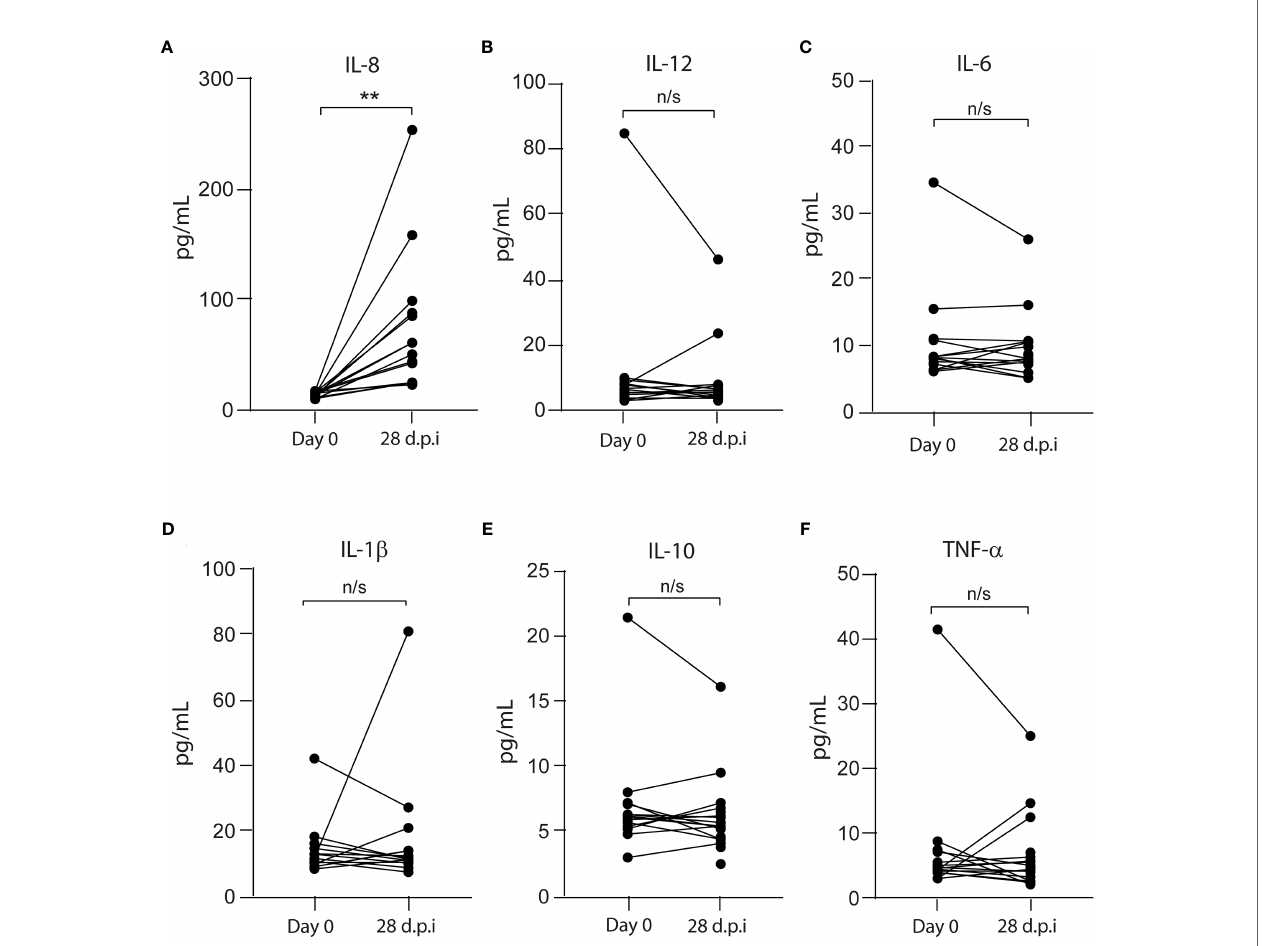
FIGURE 1 | Pro- and anti-in fl ammatory cytokines in the plasma from CoronaVac-vaccinated volunteers. The levels of (A) IL-8, (B) IL-12, (C) IL-6, (D) IL-1 b , (E) IL- 10, and (F) TNF- a were measured by fl ow cytometry as described in Materials and Methods . Data represented the cytokine level on each volunteer before (Day 0) and 28 days after the second immunization (dpi). The data show individual paired values. Asterisk (**) represents signi fi cant difference ( p < 0.01). n/s indicates non- signi fi cant